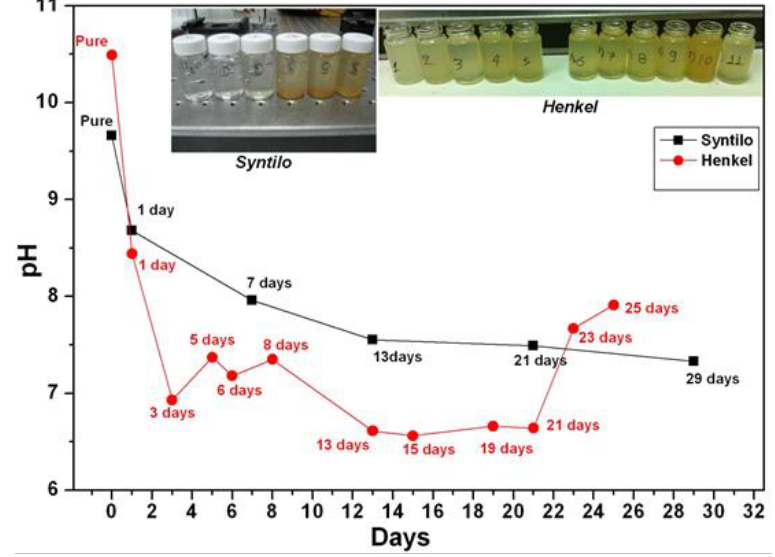
Figure 2. pH characterization of Castrol and Henkel coolant fluids at different degrees of ageing (days